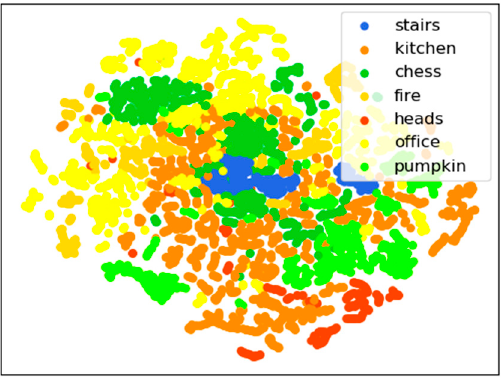
Figure 6. Latent space of the 7-Scenes dimensionality reduction based on t-SNE [56].